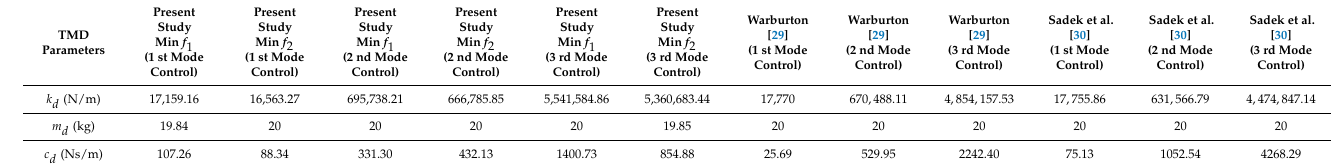
Table 1. Optimal TMD parameters designed for cantilever